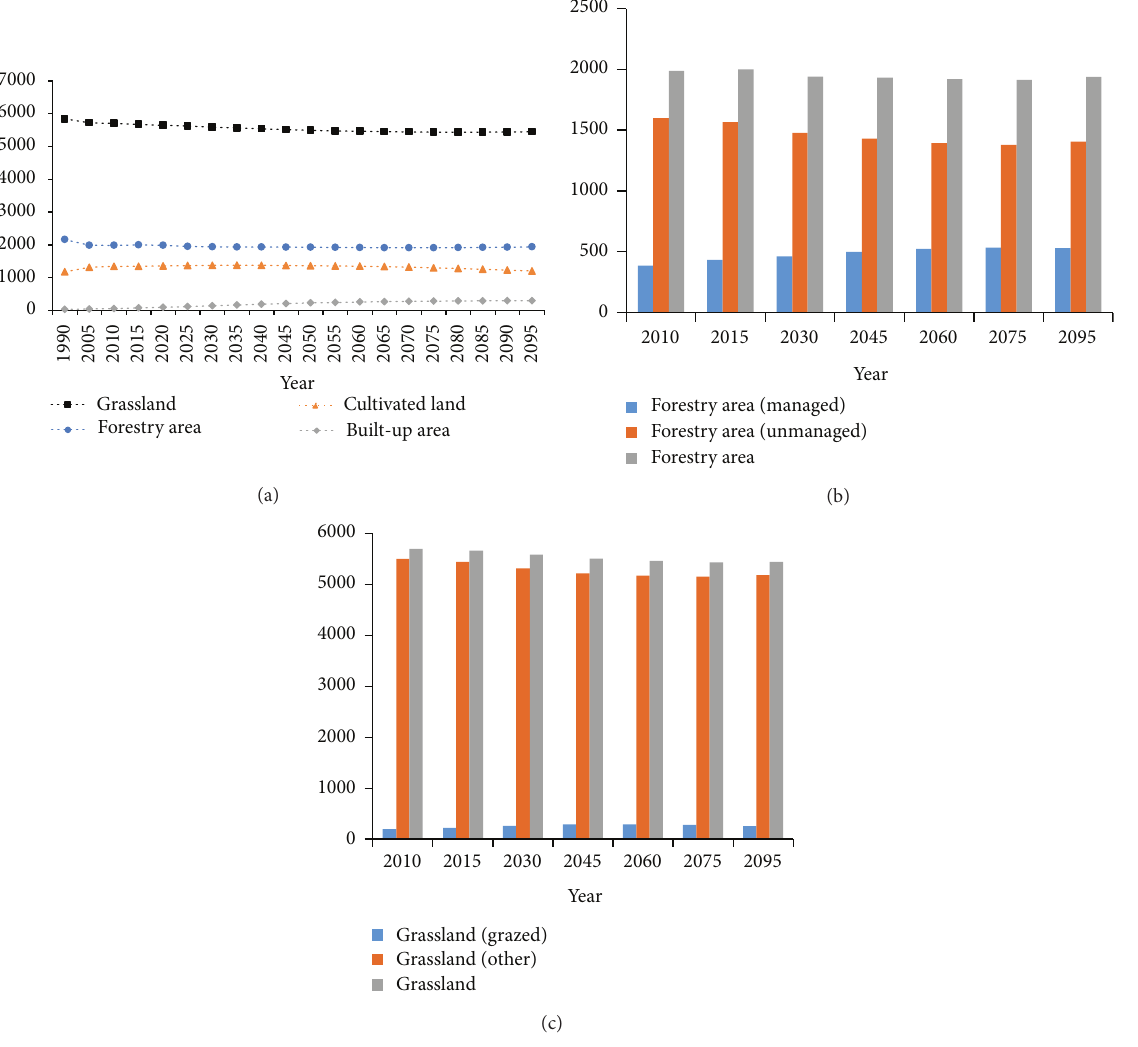
Figure 3: Land use change trends of China under BAU scenario during 1990–2095: (a) land use change trends of cultivated land, forest land, grassland, and built-up land; (b) trends of managed and unmanaged forest land; (c) trends of grazed and other grassland (unit: 1000km 2 ). Table 4: The simulation accuracy of land use allocation (unit: